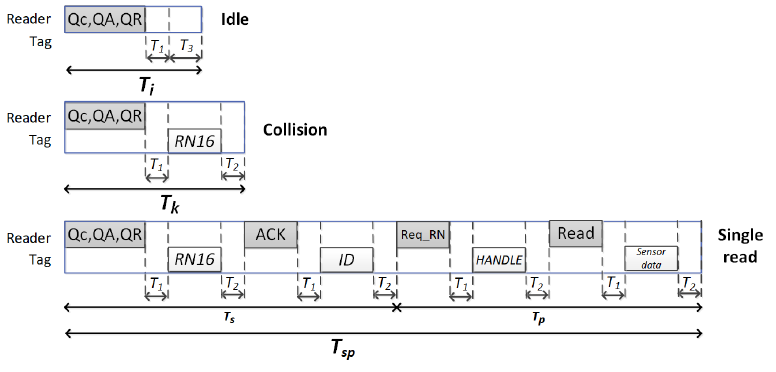
Figure 1. Transmission model of EPC Class 1 Generation 2 (C1G2).